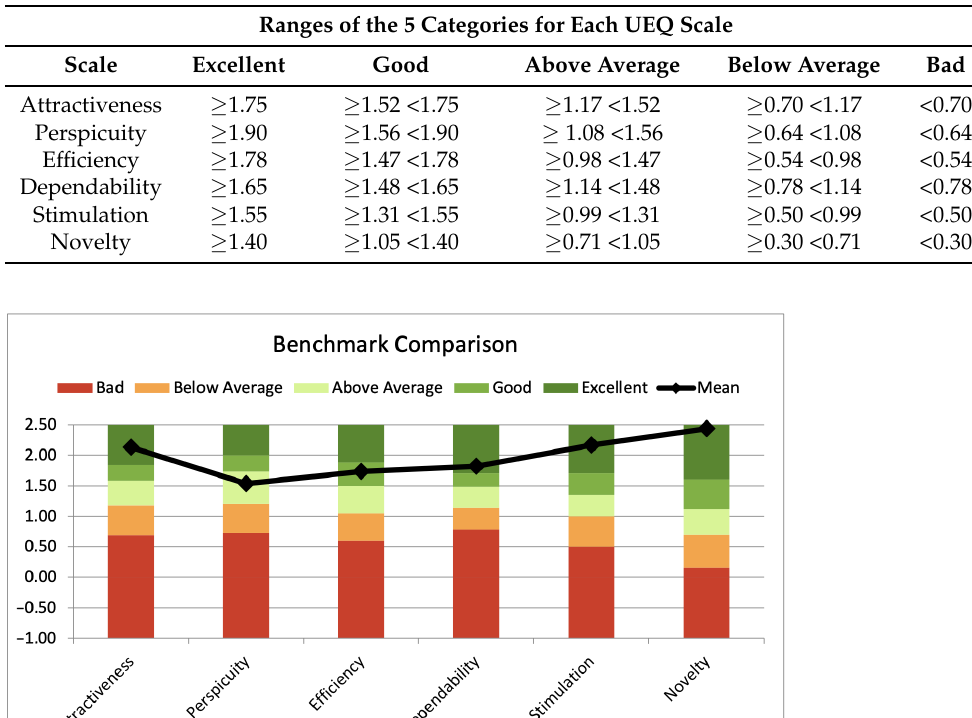
Figure 7. Mean value of each UEQ scales. Table 2. Reference ranges of the five categories for each scale (Attractiveness, Perspicuity, Efficiency, Dependability, Stimulation, and Novelty) [37].